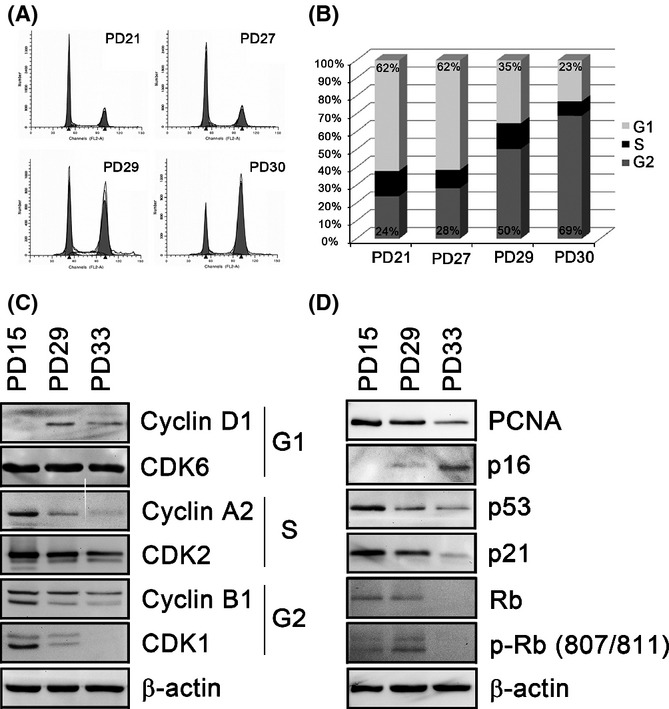
Normal human keratinocytes (NHKs) undergo G2 cell cycle arrest during replicative senescence. (A) NHKs at different PDs were analyzed for the cell cycle using flow cytometry. (B) The proportion of the cells in different cell cycle phases at different PDs was presented using a graph. (C) NHKs at early (PD15), middle (PD29), and senescent (PD33) stages were collected and subjected to Western blotting against cyclin D1, cyclin A2, cyclin G2, CDK6, CDK2, and CDK1. (D) The same NHKs at the same PDs were also subjected to Western blotting against PCNA, p16, p53, p21, Rb, and p-Rb (807/811). β-Actin was used as a loading control.